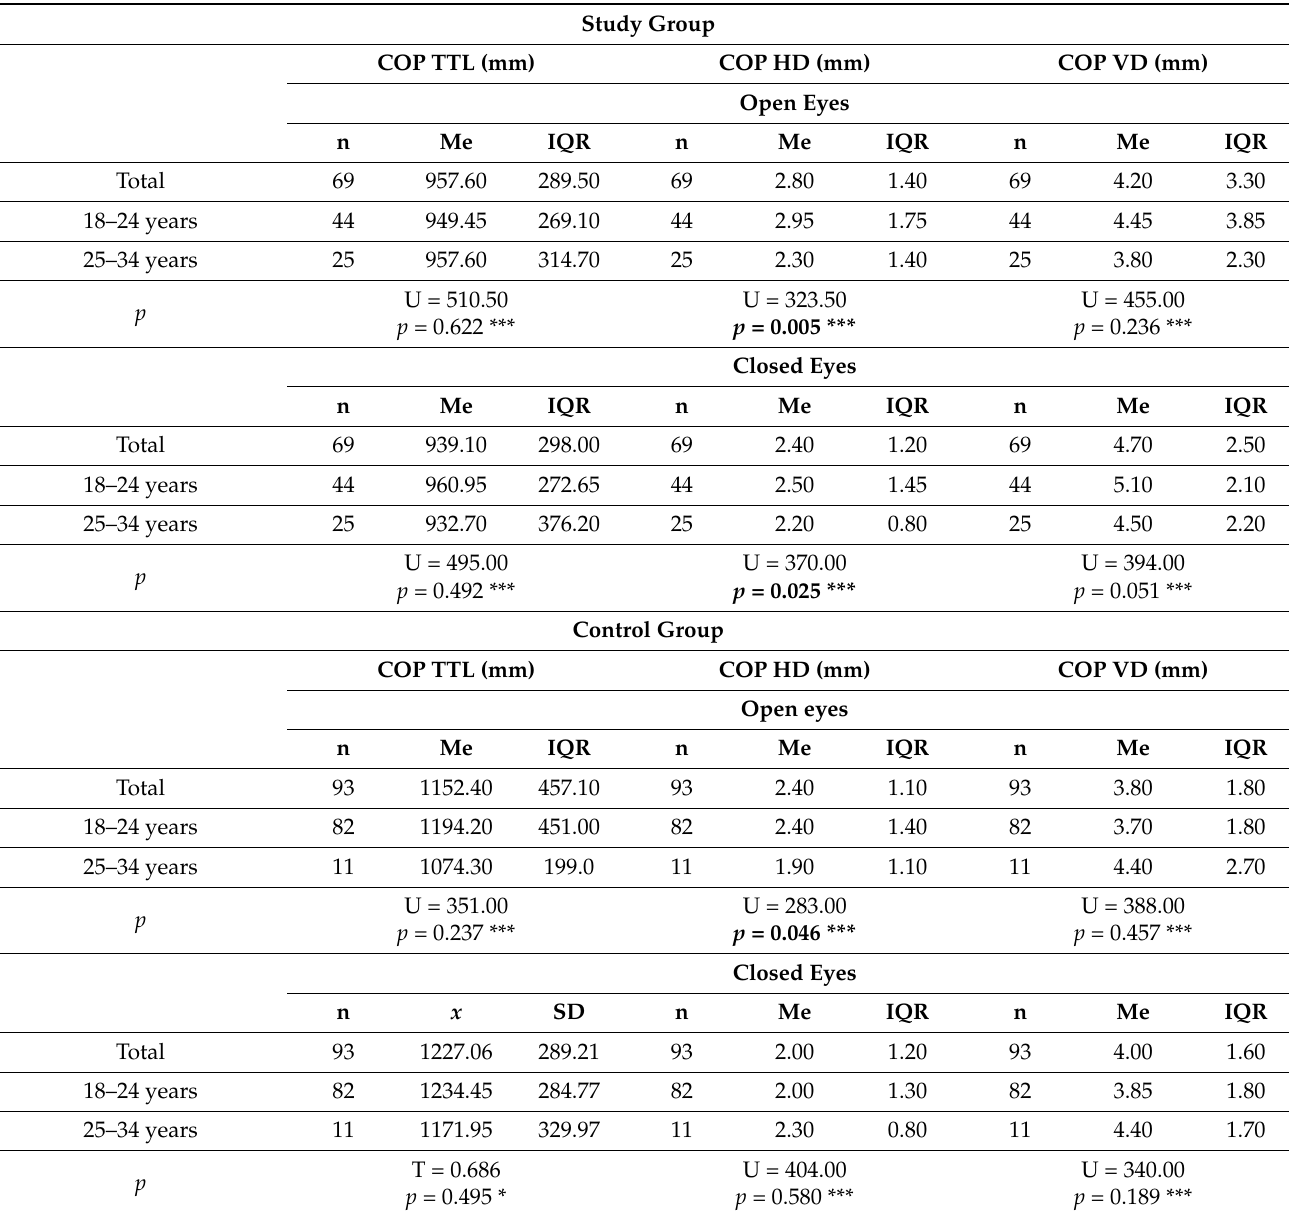
Table 2. Differences in the values of the center-of-pressure depending on the age of the participants. Study